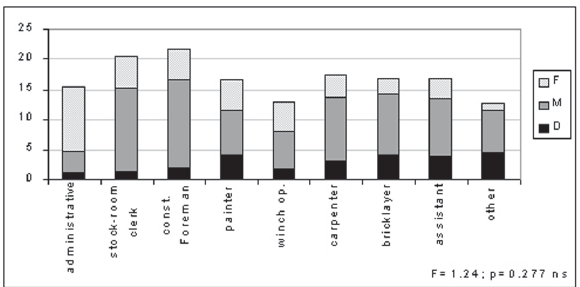
FIGURE 4- Sample distribution according to mean (sd) number of teeth presenting no dental treatment needs. Bauru, Brazil, 2001